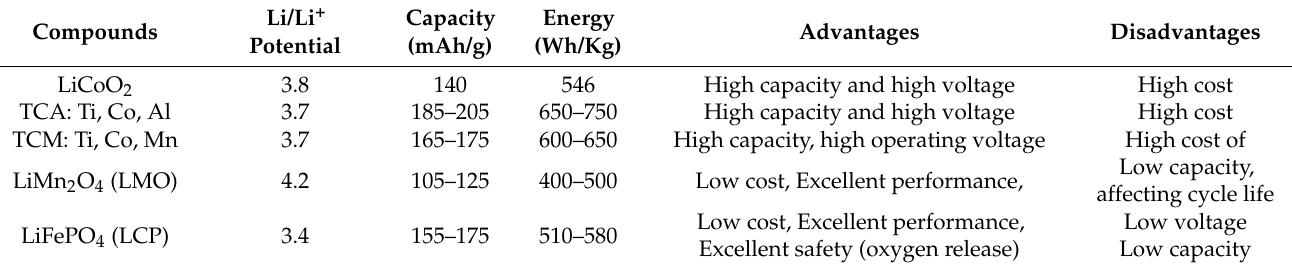
Table 1. Commercial Characteristics of Cathode materials